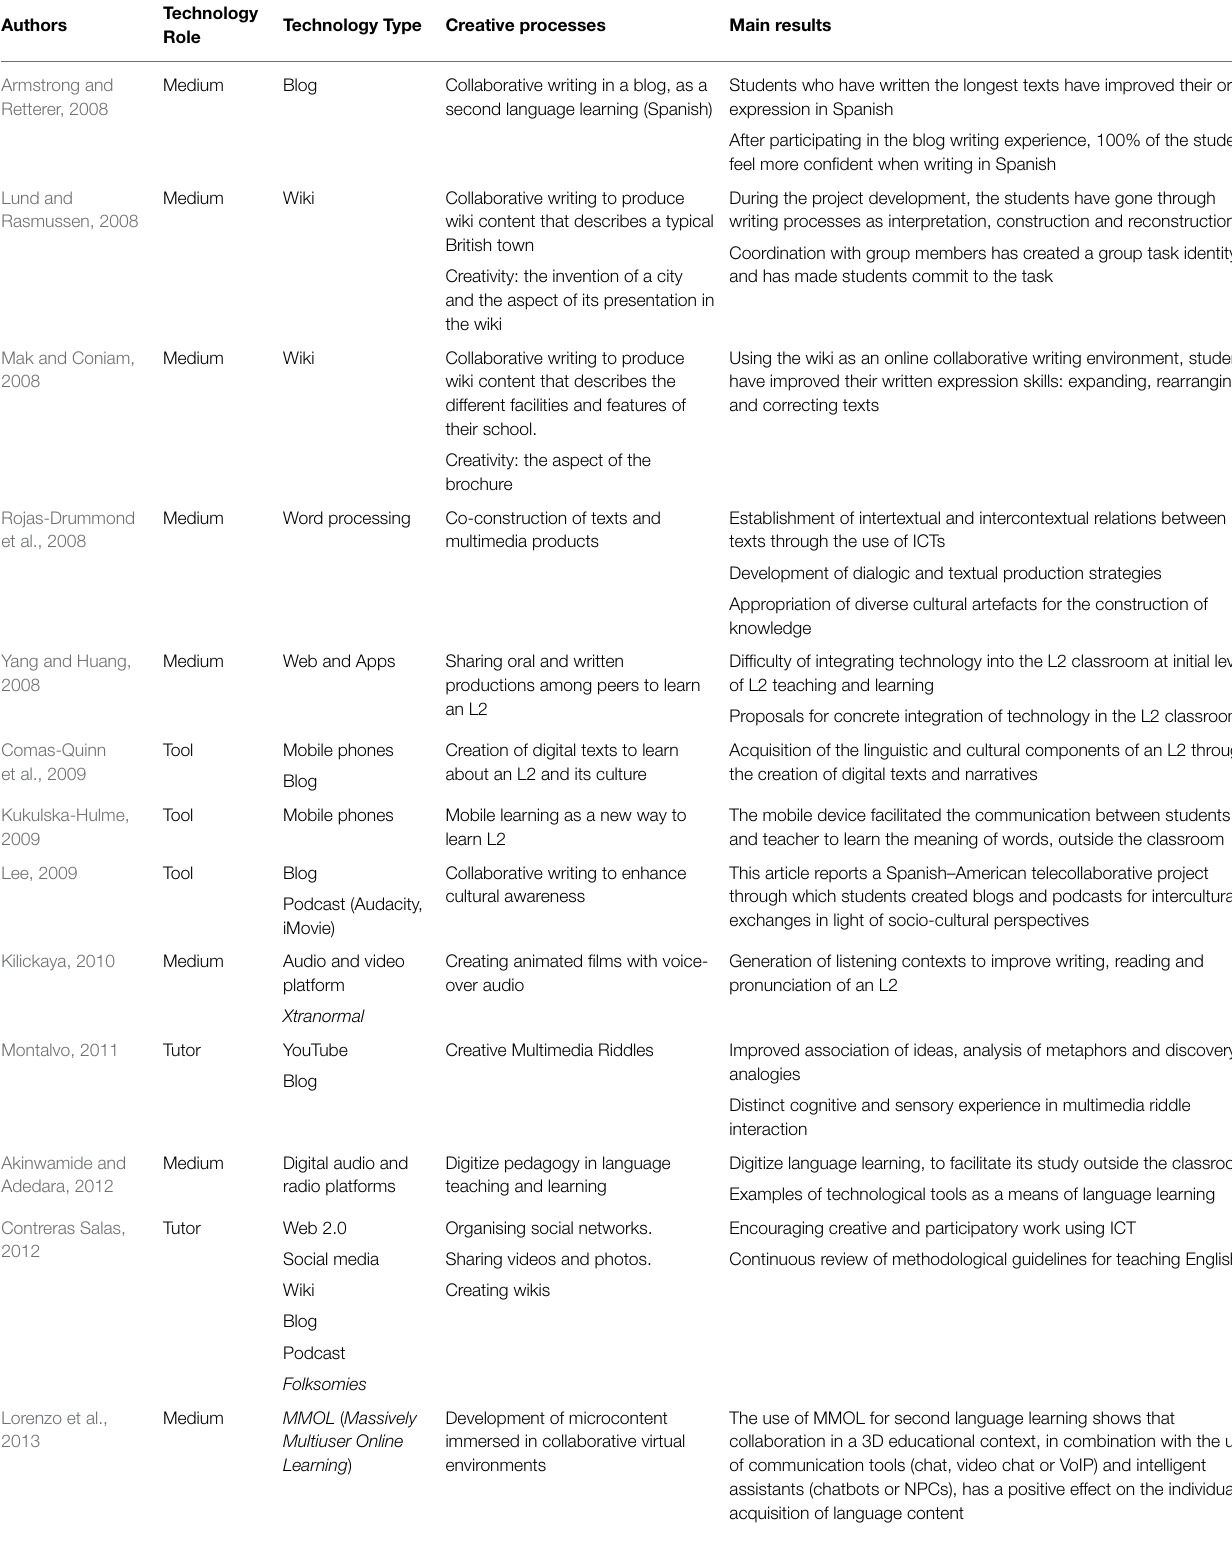
TABLE 2 | Summary of review studies reporting on collaborative creativity practices with technology in the teaching and learning of languages.